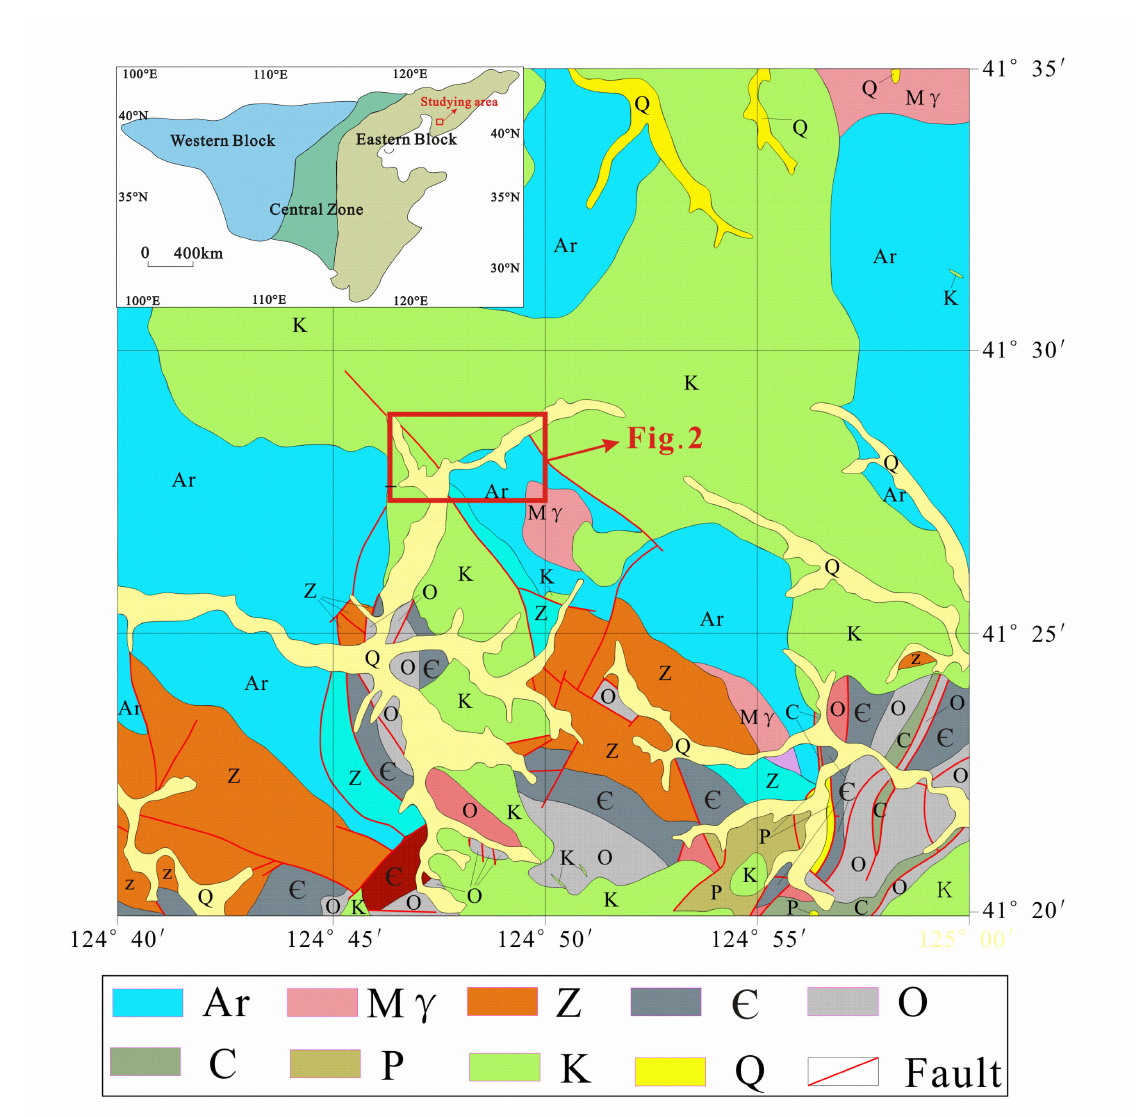
Figure 1. Regional geologic map of Lijiapuzi. Ar-Archean metamorphic rocks; M γ -Archean migmatitic granite; Z-Sinian shale and limestone; ∈ -bitumen bearing shale and limestone; O- dolomitic limestone; C-carbonaceous shale; P-quartz sandstone; K-sandstone interlayer with andesite;